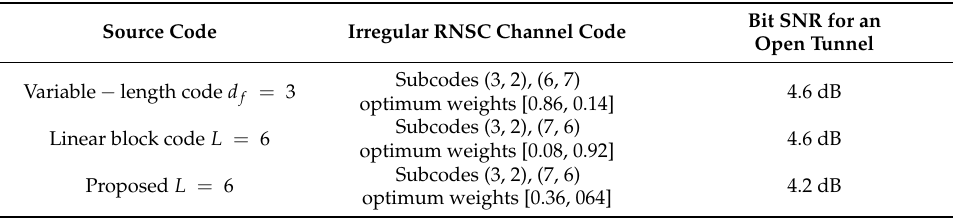
Table 4. Parameters of irregular RNSC code matched with different source